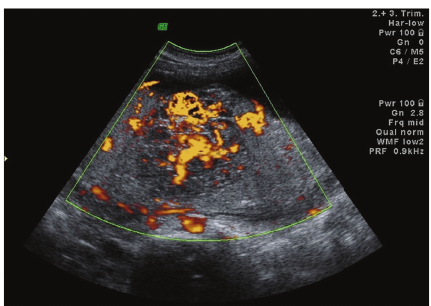
Figure 2: The power Doppler ultrasonography of the placental angioma of Case 1 showing rich vascular supply within.